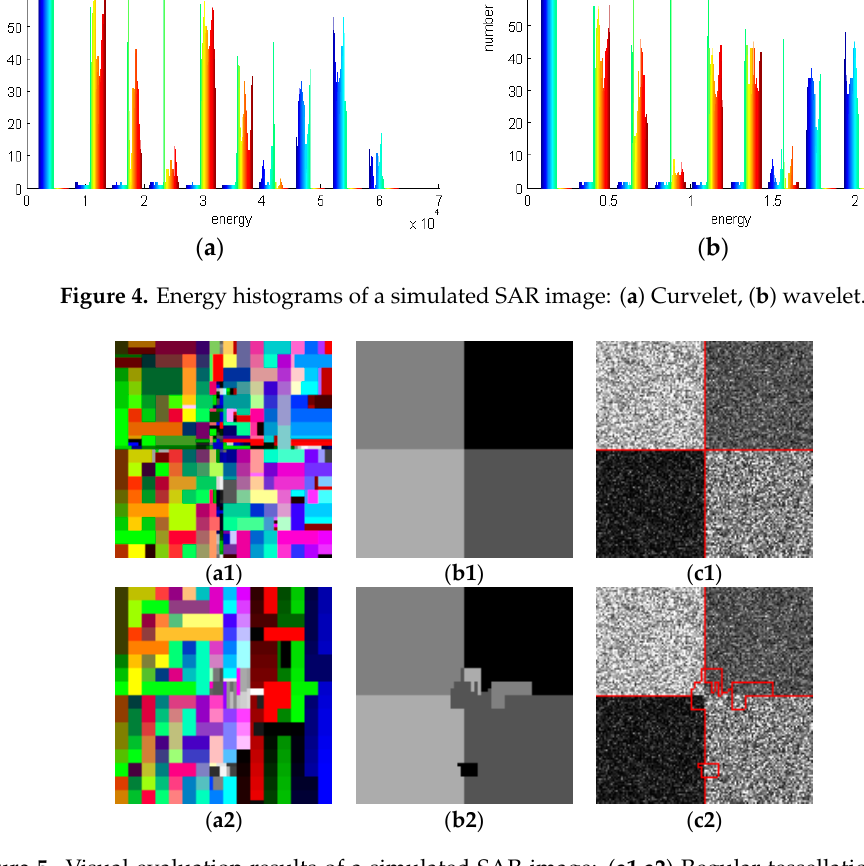
Figure 5. Visual evaluation results of a simulated SAR image: ( a1 )–( a2 ) Regular tessellation, ( b1 )–( b2 ) segmentation result, ( c1 )–( c2 ) extracted outlines on the original image.